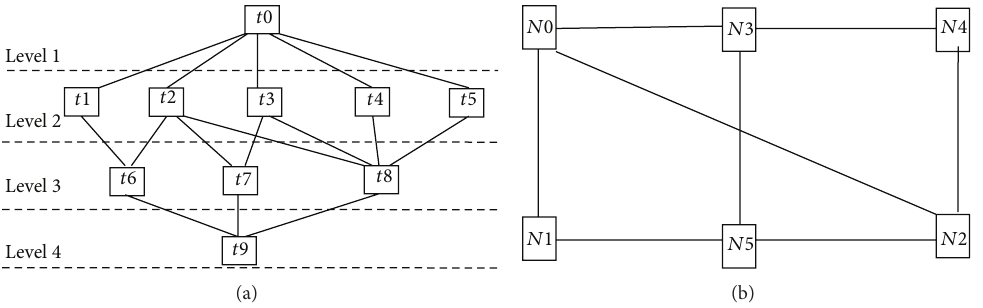
Figure 1: (a) DAG based sample task t ; (b) virtual network